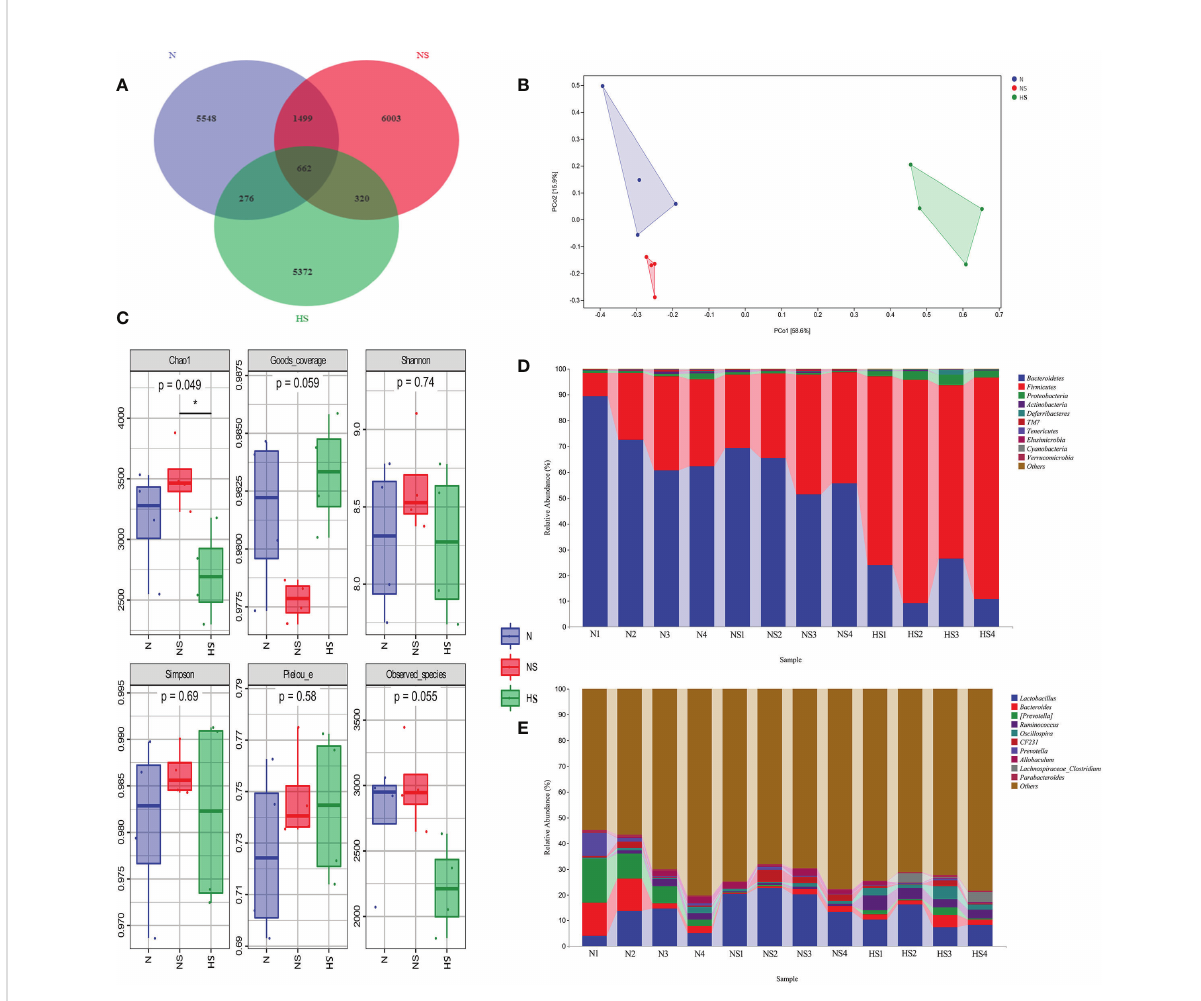
FIGURE 5 Effect of Terminalia bellirica (Gaertn.) Roxb. on intestinal microbiota composition in Salmonella Typhimurium -challenged mice. (A) Fecal micro fl ora of mice analyzed by a Veen diagram. Relative abundance of gut bacterial taxa among different groups. (B) Principal component analysis (PCA) of the fecal microbiota; PCA map based on Euclidean distance. Each point indicates one sample; the distance of the two points indicates the difference in fecal microbiota. (C) Diversity indices of the fecal microbiota in different groups; Chao1, Goods_Coverage, Shannon, Simpson, Pielou ’ s_e, and Observed indices were used to evaluate the alpha diversity of the fecal microbiota. (D) Phylum level. (E) Genus level. The results were evaluated through one-way ANOVA. All the data represent means ± SD. * P <